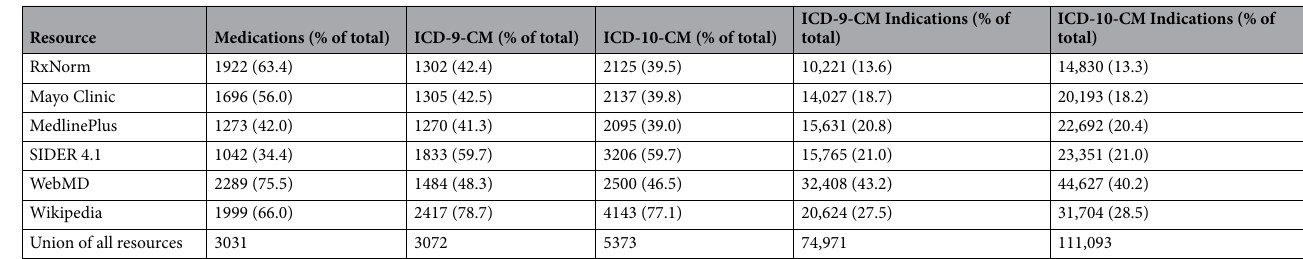
Table 1. Summary of counts of medications, ICD codes, and indications for MEDI-2.